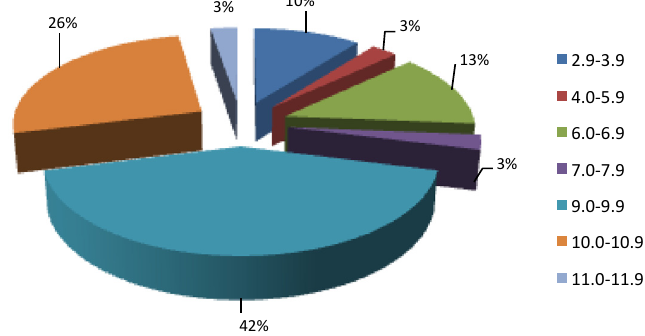
Figure 4. Isoelectric point range distribution of AEP natural occurring peptides at pH